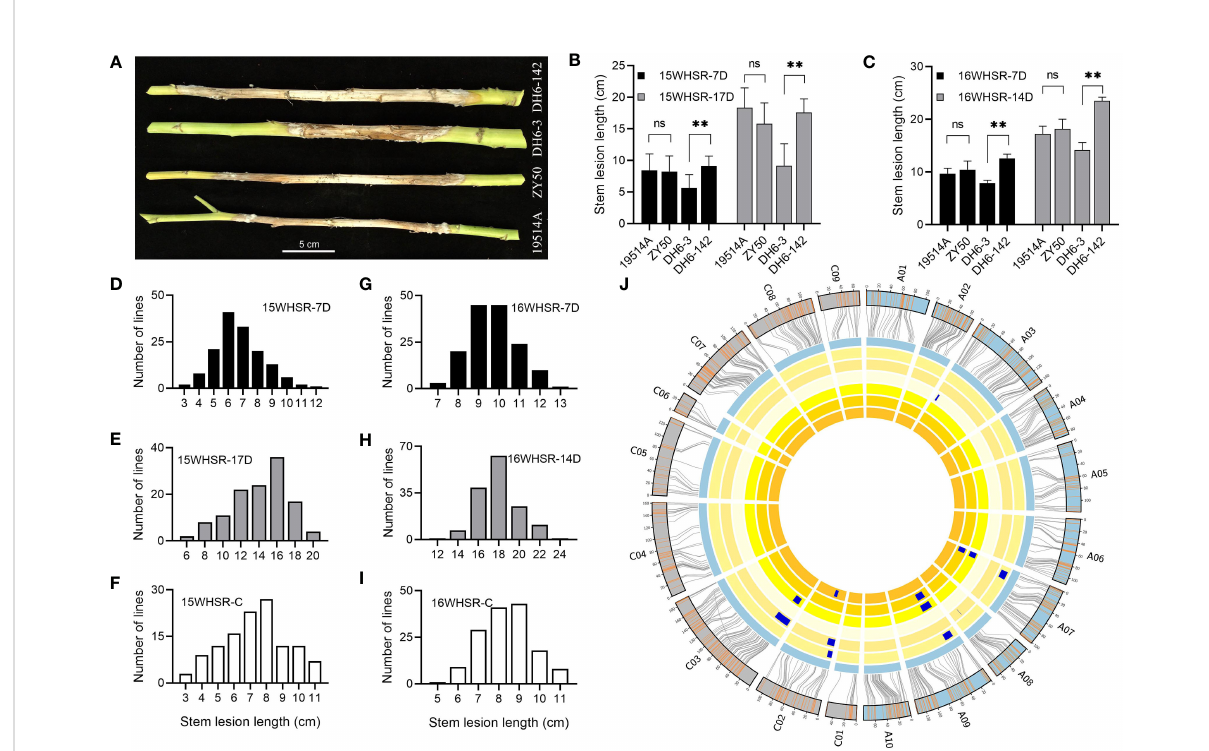
FIGURE 1 Phenotype and quantitative trait loci (QTL) mapping of stem resistance assay. (A) Disease lesions on the stems of the two parents and two double haploid (DH) lines at 14 days post-infection (dpi). Bar = 5 cm. (B, C) Stem lesion lengths of the two parents and two DH lines in 2015 and 2016. “ -7D ” indicates the data from the fi rst measurement at 7 dpi and “ -14D ” and “ -17D ” indicate the data from the second measurement. Data are shown as the mean ± SD; ns indicates no signi fi cant difference, **P < 0.01 (one-way analysis of variance). (D-I) Distribution of stem lesion lengths of the DH population in 2015 (D – F) and 2016 (G – I) . “ -C ” indicates the difference between the two measurements. (J) Genetic linkage map and locations of QTLs for stem resistance (SR). From inside to outside, the six cycles represent 15WHSR-7D, 15WHSR-17D,